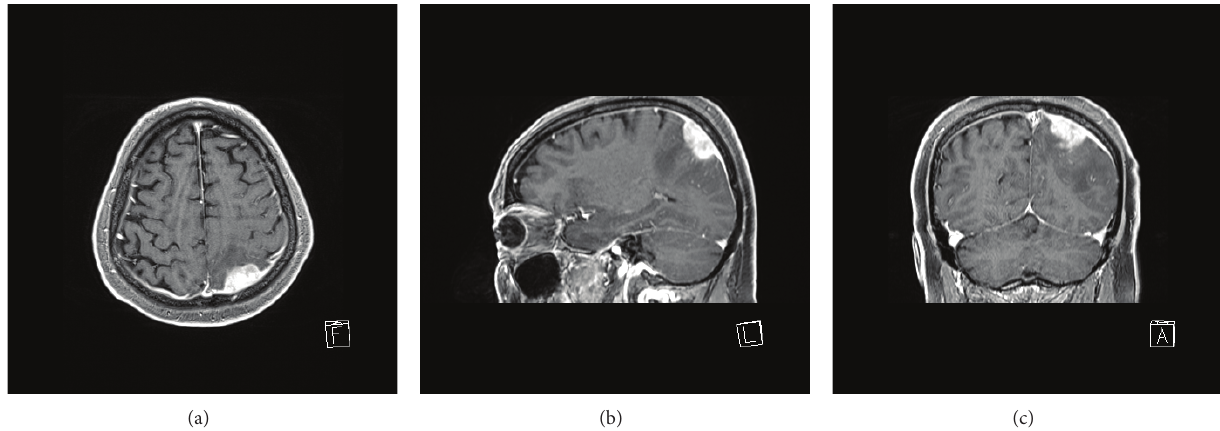
Figure 1: Gd-enhanced, T1-weighted MRI: axial (a), sagittal (b), and coronal (c) view of the brain granuloma; differential diagnosis with other extra-axial lesions is challenging.